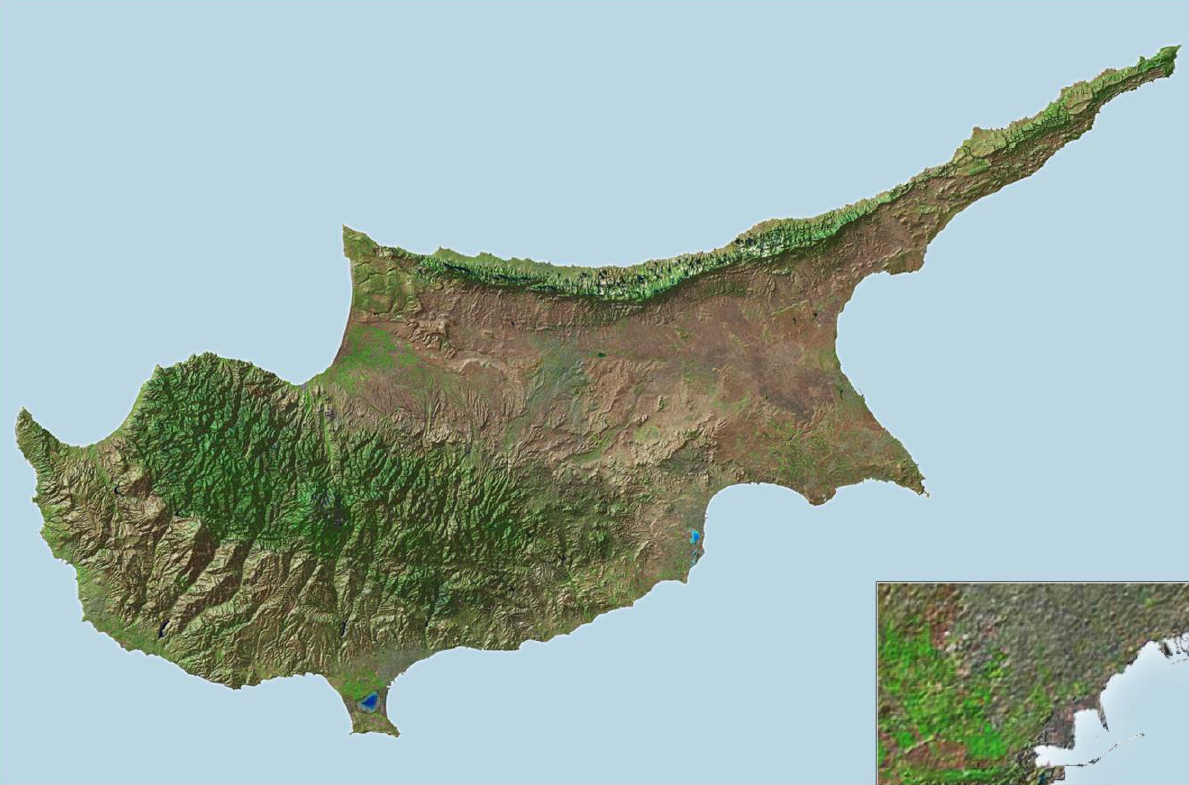
Figure 4. Composition of the NASA_P image with SRTM-1. Note: fragment in full resolution in the